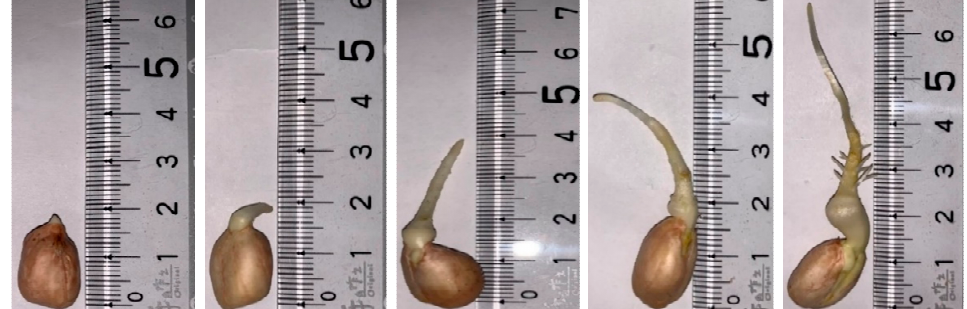
Figure 1. Growth of Tainan 12 peanuts germinated for 1 to 5 days. As the moisture content of the germinated peanuts increased to 35% after soaking, it was necessary to air dry the germinated peanuts at 45 °C for 14 h to bring the moisture content close to 10% prior to storage and subsequent resveratrol and GABA content analysis (Figure 2). The resveratrol content in peanut is not detected internally, and is produced during germination. The peanuts contained 2.25 and 4.02 μ g/g of resveratrol on the first and second days of germination, respectively, after which its generation slightly slowed down; however, the GABA content of the peanuts continued to rise from day one to day five of germination, from 258.8 μ g/g on the second day of germination to 666 μ g/g on the fifth day.